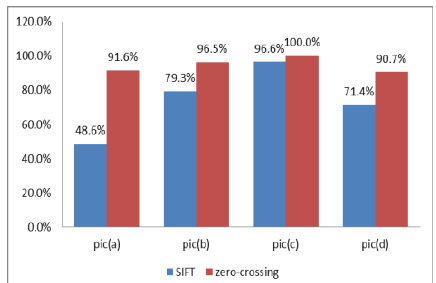
Figure 3(c) matching correct rate of SIFT algorithm and zero- crossing algorithm. Blue bar for SIFT algorithm and red bar for zero-crossing algorithm. The x-axis showed different group of test images and the y-axis stands for the matching correct rate.